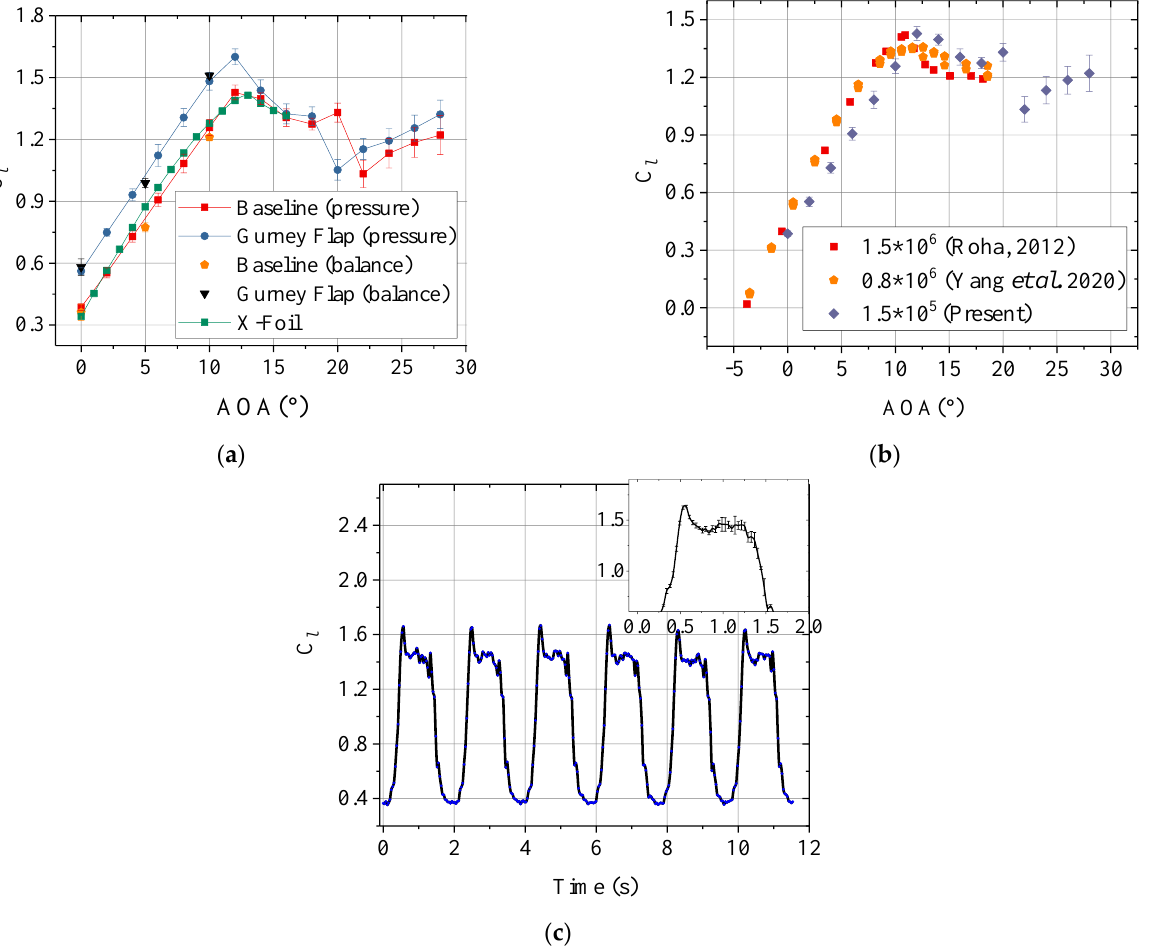
Figure 4. Validation of the aerodynamic results of DTU-LN221 airfoil. ( a ) Static state ( b ) Reynolds effect ( c ) Dynamic state.